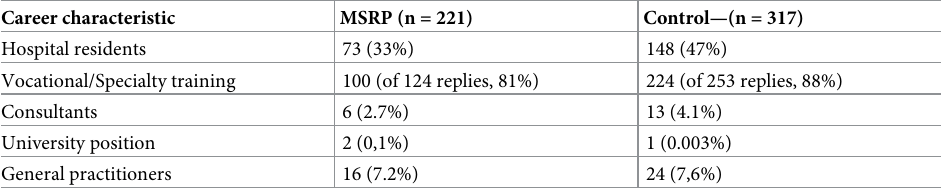
Table 1. Reported career characteristics among Norwegian MDs who had been enrolled in the Medical Student Research Program (MSRP) or had followed the regular undergraduate medical curriculum, the 2006–14 cohort. Career